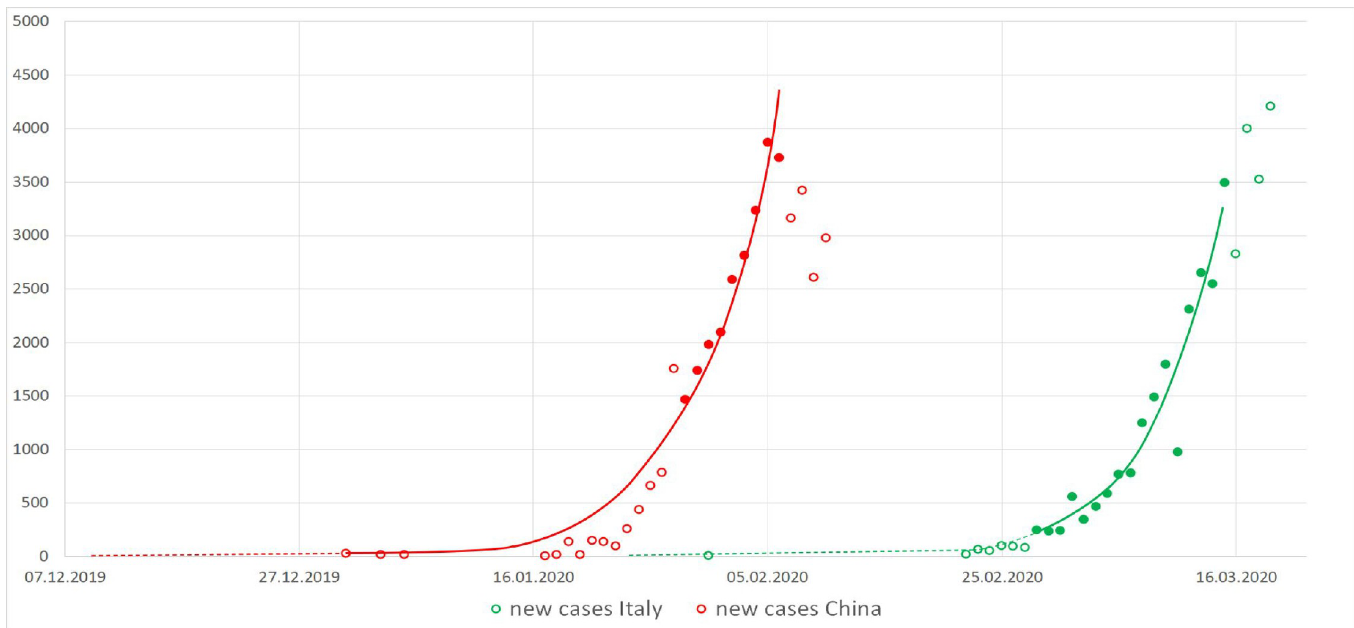
Fig 2. Exponential fit of new cases. The full line over a selected portion of data represents the exponential fit. Data represented by the dots could be identified as exponentially behaved in contrast to the empty